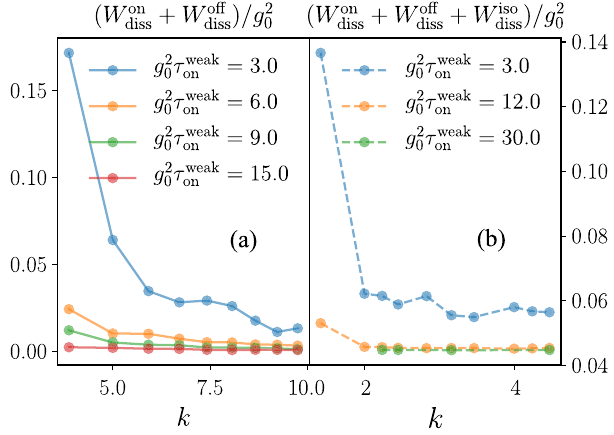
FIG. 8. (a) Dissipated work for turning on and off the interaction in the CL model. For different values of τ weak error induced by going to the strong coupling regime decreases to zero. Parameters are N ¼ 300 , g 2 0 = ω (b) Dissipated work for full protocols. The total dissipation decays as the interaction increases. For different values of τ weak the error induced by going to the stronger coupling regime decreases to zero. The protocol consists on modifying the frequency of the systems from ω i